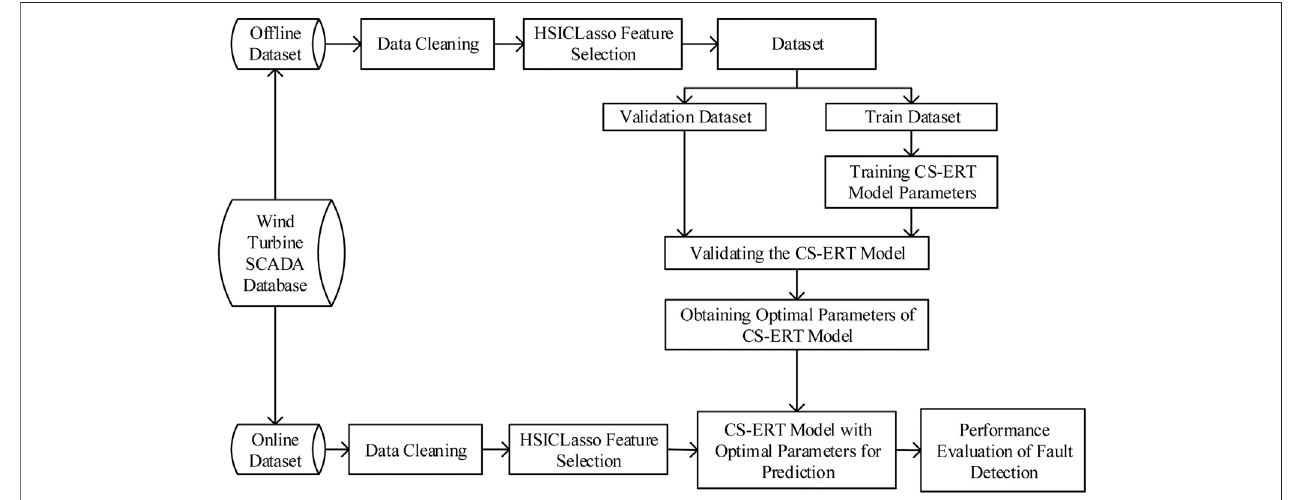
FIGURE 3 | Flowchart of wind turbine generator fault detection based on